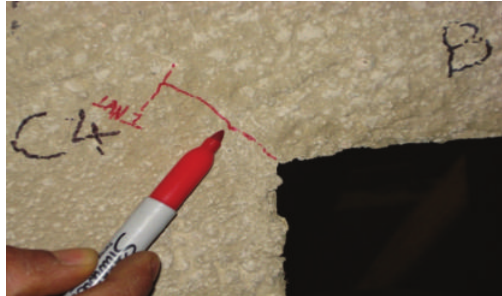
Figure 10: Shear crack in the column of the SDA concrete frame after test sequence